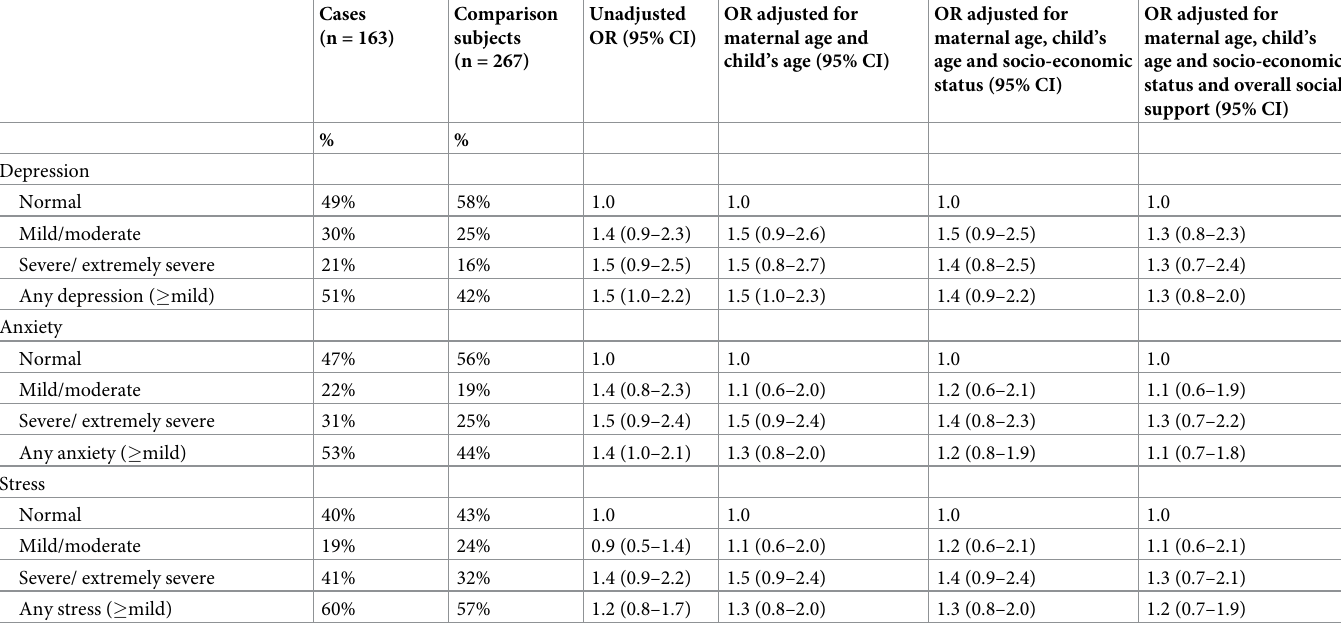
Table 3. Depression, anxiety and stress in mothers with a child with CZS, and comparison